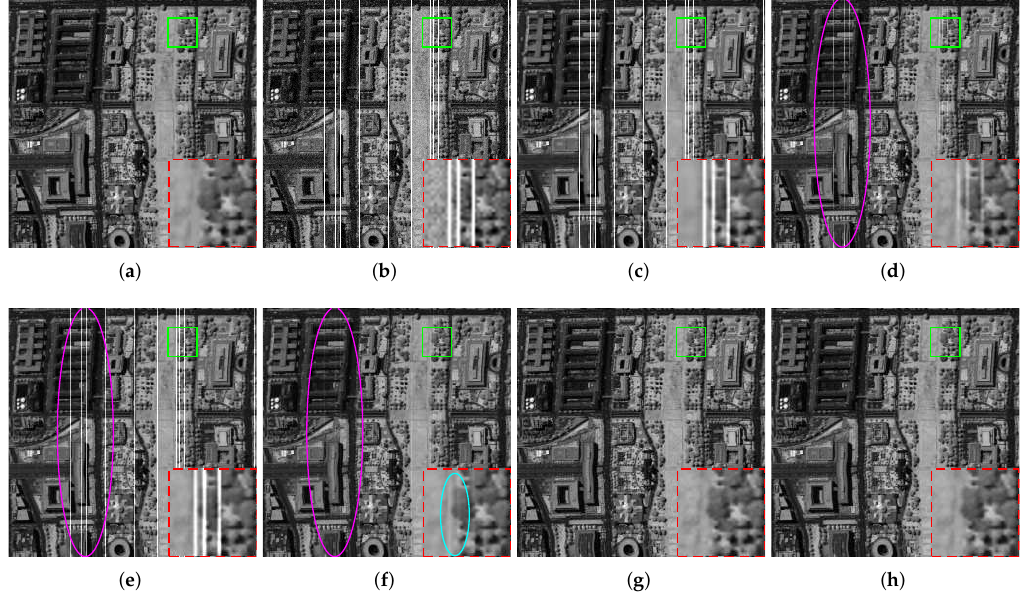
Figure 6. Restoration results of band 84 for WDC dataset (the red box illustrates the zoom-in portion in the blue box). ( a ) Noisy-free image; ( b ) noisy image (PSNR = 16.99 dB); ( c ) BM4D (PSNR = 17.75 dB); ( d ) LRMR (PSNR = 29.04 dB); ( e ) LRTV (PSNR = 18.92 dB); ( f ) 3DTVLR (PSNR = 33.61 dB); ( g ) LRRSDS (PSNR = 35.03 dB); ( h ) SDTVLA (PSNR = 35.86